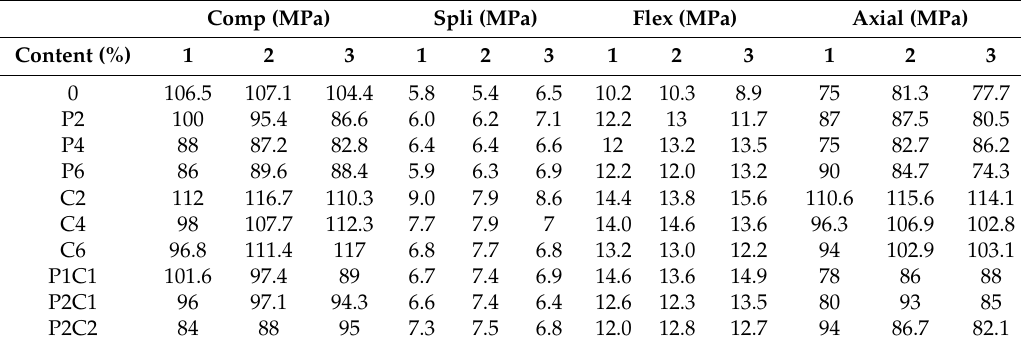
Table 4. Mechanics test value of concrete at room temperature.